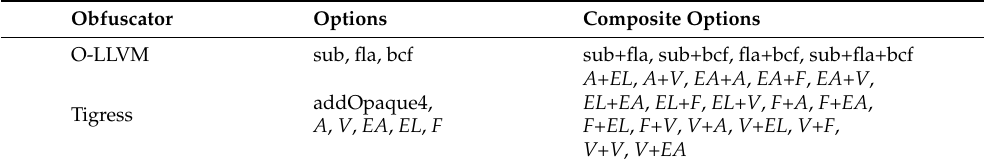
Table 2. All obfuscation options in O-LLVM and Tigress. (Note: A is short for addOpaque16 , V is short for Virtualize , EA is short for EncodeArithmetic , EL is short for EncodeLiterals and F is short for Flatten . A+V represents a composite option of addOpaque16 and Virtualize , and others are the same.) Obfuscator